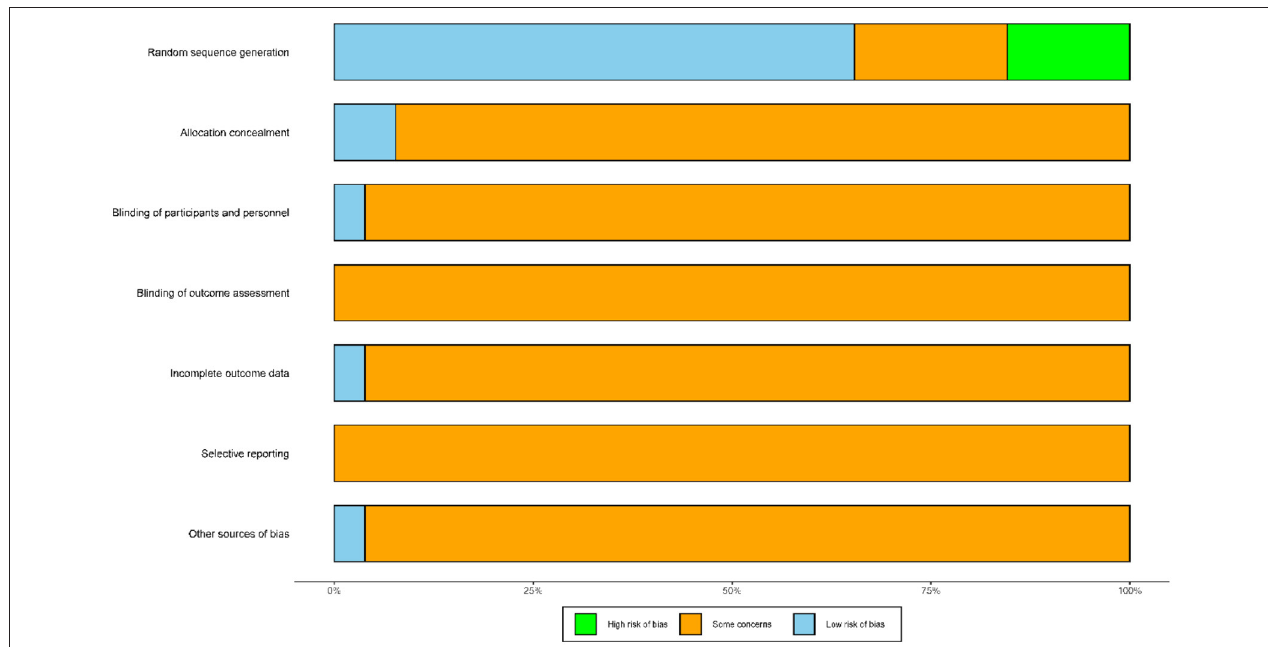
FIGURE 2 | Risk of bias of the included studies. The vertical axis represents the quality evaluation items and the horizontal axis represents the number of studies.